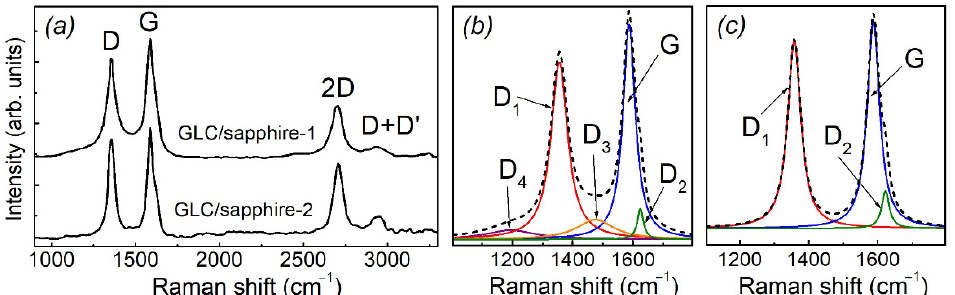
Figure 4. Raman spectra of carbon films, deposited on sapphire substrates ( a ), and first-order fitted spectra of the samples GLC/sapphire-1 ( b ) and GLC/sapphire-2 ( c ).